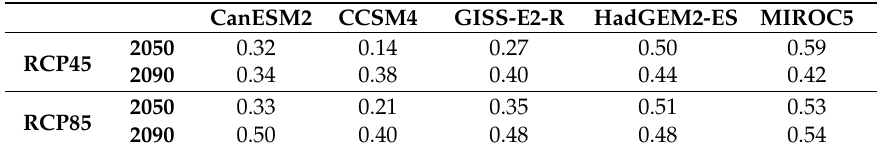
Table 3. Correlation coefficients of changes in WTP across the Ecoregions between HAWQS and US Basins.